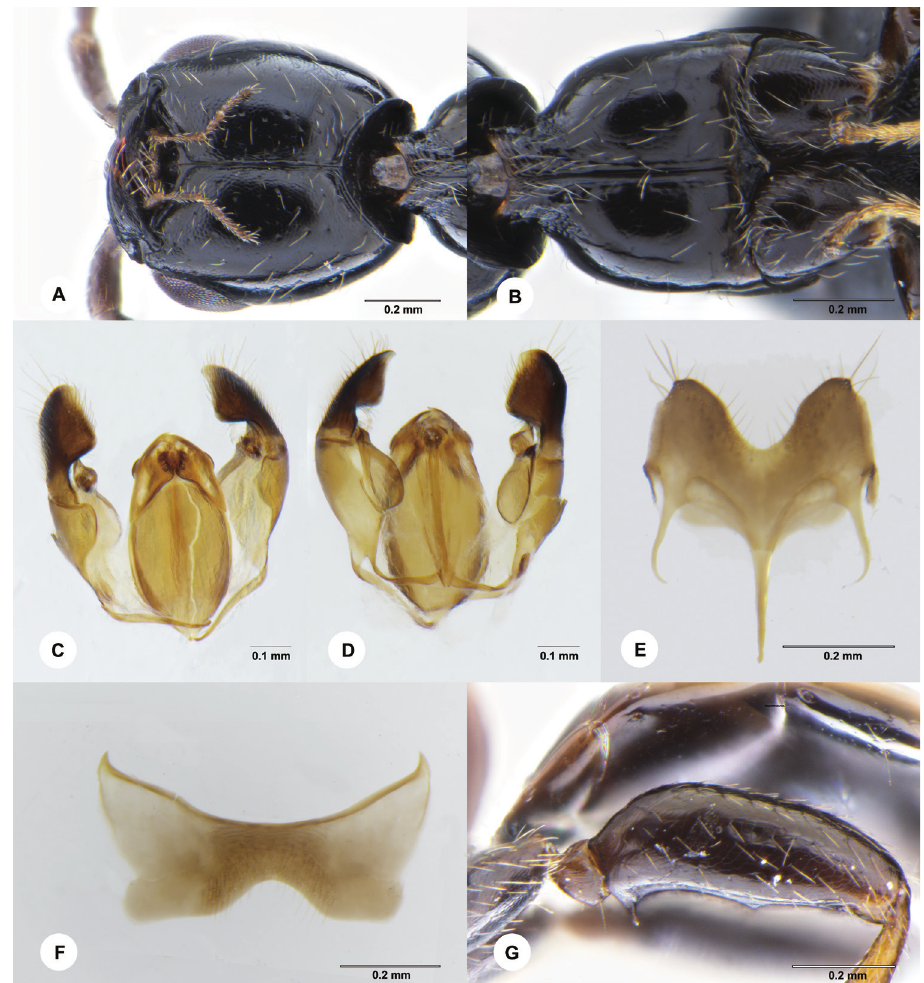
C–F paratype (SCAU 3042641) A head, ventral view B mesosoma, ventral view C genitalia, dorsal view D genitalia, ventral view E subgenital plate F 7 th sternite G metaleg, lateral